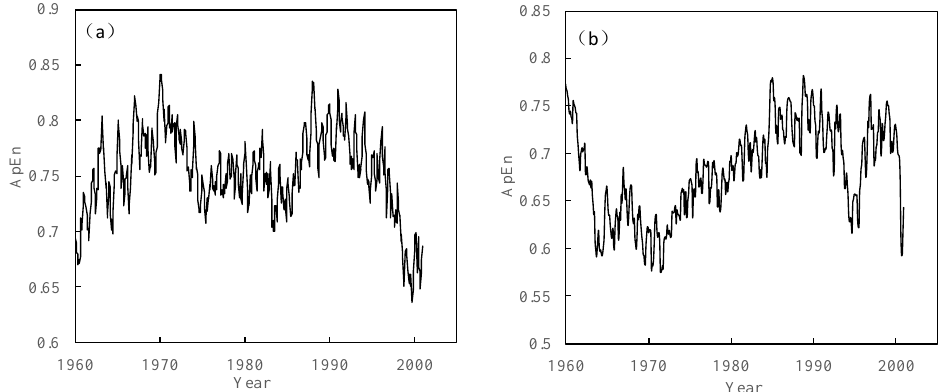
Figure 6. The moving approximate entropy (M-ApEn) of monthly mean precipitation ( a ) and runoff